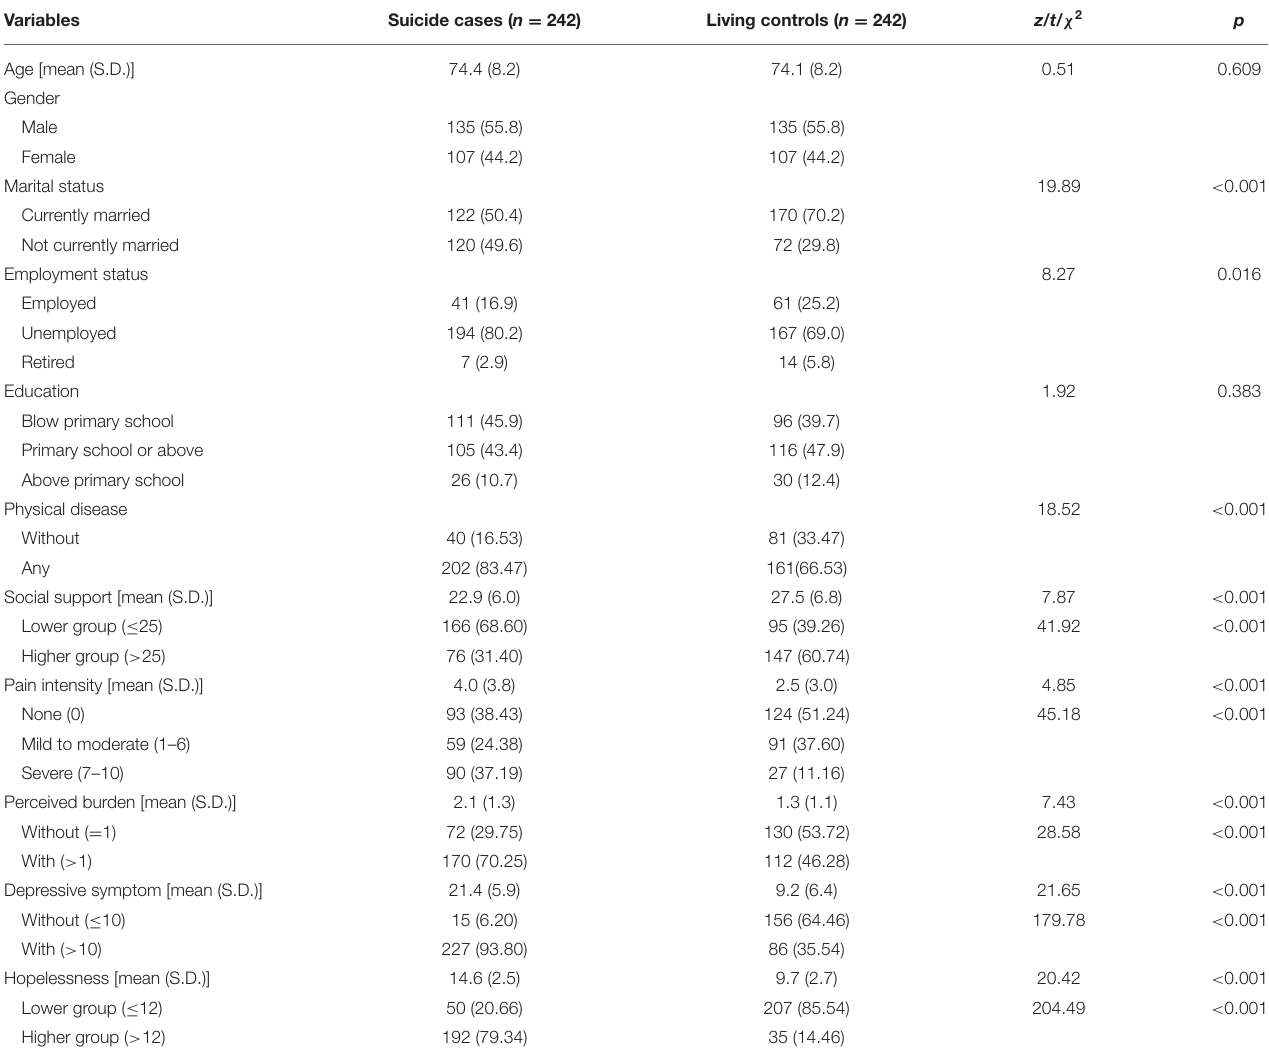
TABLE 1 | Characters of suicide cases and living